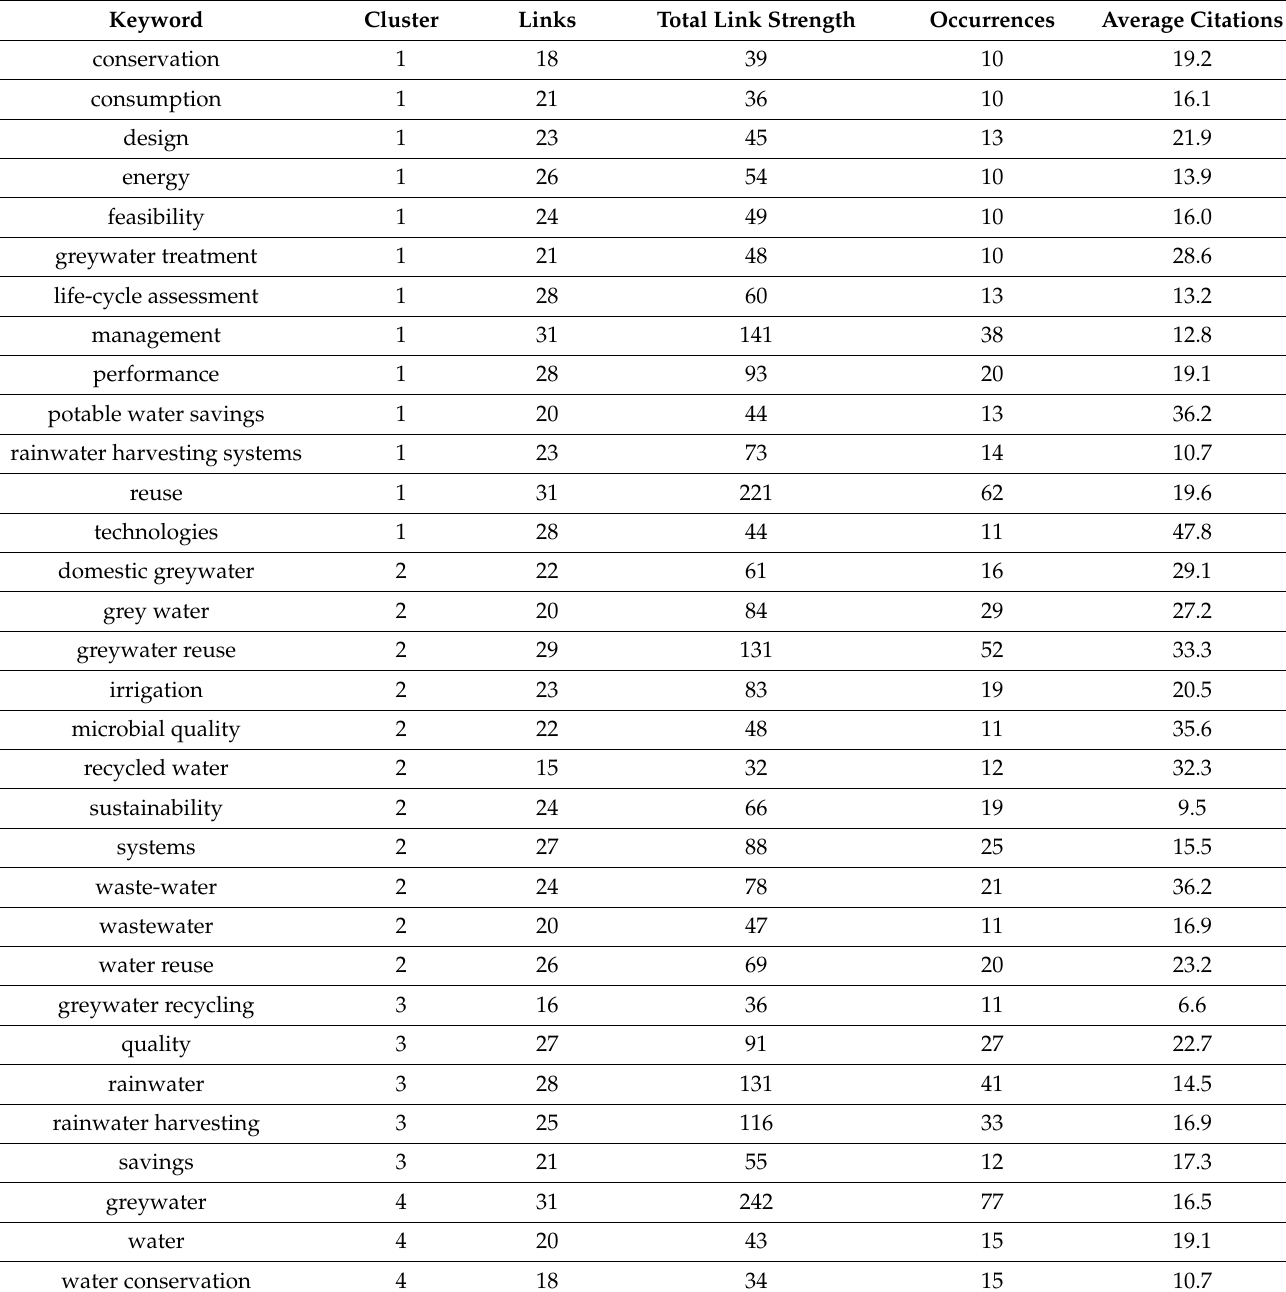
Table 10. The most popular keywords in greywater recycling